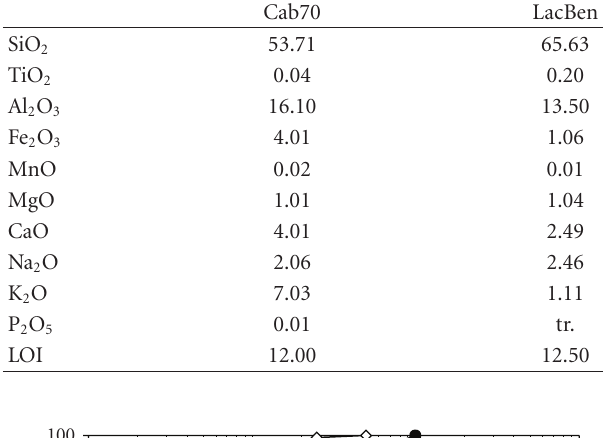
Table 2: Chemical composition of Cab70 and LacBen (wt. %, XRFS).